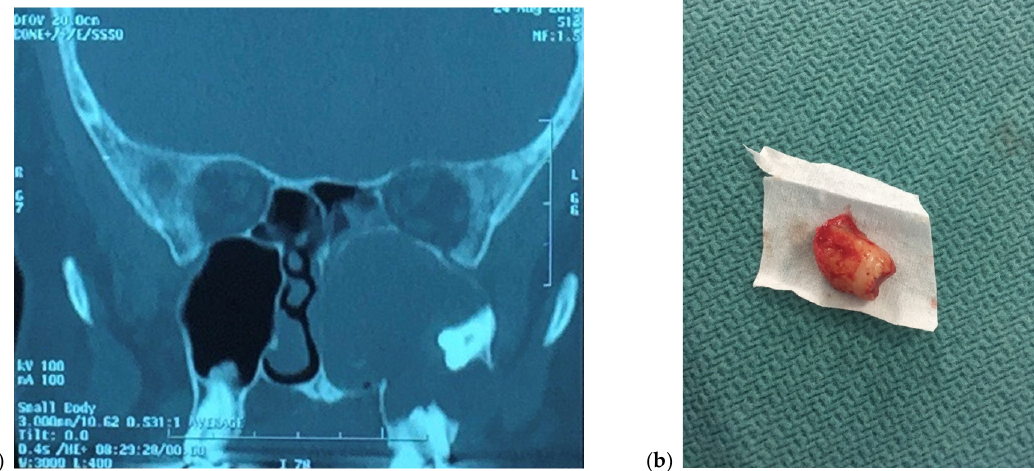
Figure 3. ( a ) Computed tomography demonstrating left maxillary sinusitis secondary to a dentigerous cyst, and; ( b ) tooth extracted from dentigerous cyst after Modified Medial Maxillectomy approach.